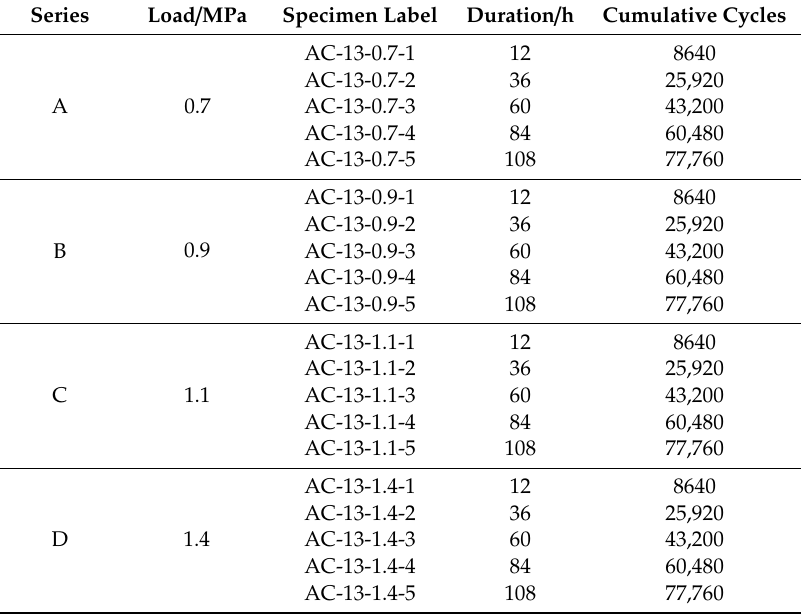
Table 2. Heavy load testing program for the AC-13 basalt asphalt